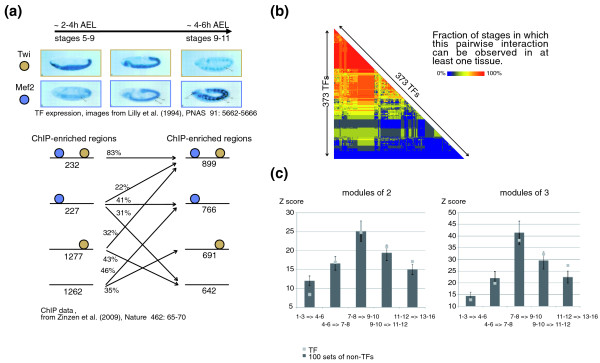
Modularity of transcription factors. (a) Expression of Twi and Mef2 and their co-occurrence at genomic sites at different developmental stages. Compared are stages 5 to 9 (approximately 2-4 h AEL) and stages 9 to 11 (approximately 4-6 h AEL). In the earlier time frame, strong mesodermal Twi expression but only weak Mef2 expression can be observed. Half of the genomic sites that see occupancy by either TF at some stage during development show only Twi occupancy (43%) or Twi/Mef2 (8%) double-occupancy. By 4 to 6 h AEL, the majority of the mesoderm develops into muscle, which is characterized by strong Mef2 expression. Genomic occupancy follows this trend, showing that most sites with previous double-occupancy maintain that state while one-third of the previous Twi-only sites gain a Mef2 partner site. Overall, more than half of the Twi sites then show double-occupancy. The images showing TF expression are reproduced from [64]. ChIP data are from [22]. (b) A map of potential pairwise interactions between transcription factors. For all of the 373 TFs for which BDGP expression data are available, the frequency of co-occurrence in at least one tissue is color-coded (as fraction of sampled time frames). Most TFs are co-expressed in at least one spatio-temporal coordinate. (c) Transcription factor expression exhibits modular behavior. More modules of two (left panel) or three (right panel) transcription factors show precisely the same expression from one to the next developmental stage than is to be expected at random. Interestingly, this is an intrinsic feature of all genes and not a specific property of the transcription factors. Error bars indicate the standard deviation observed in the random experiments.